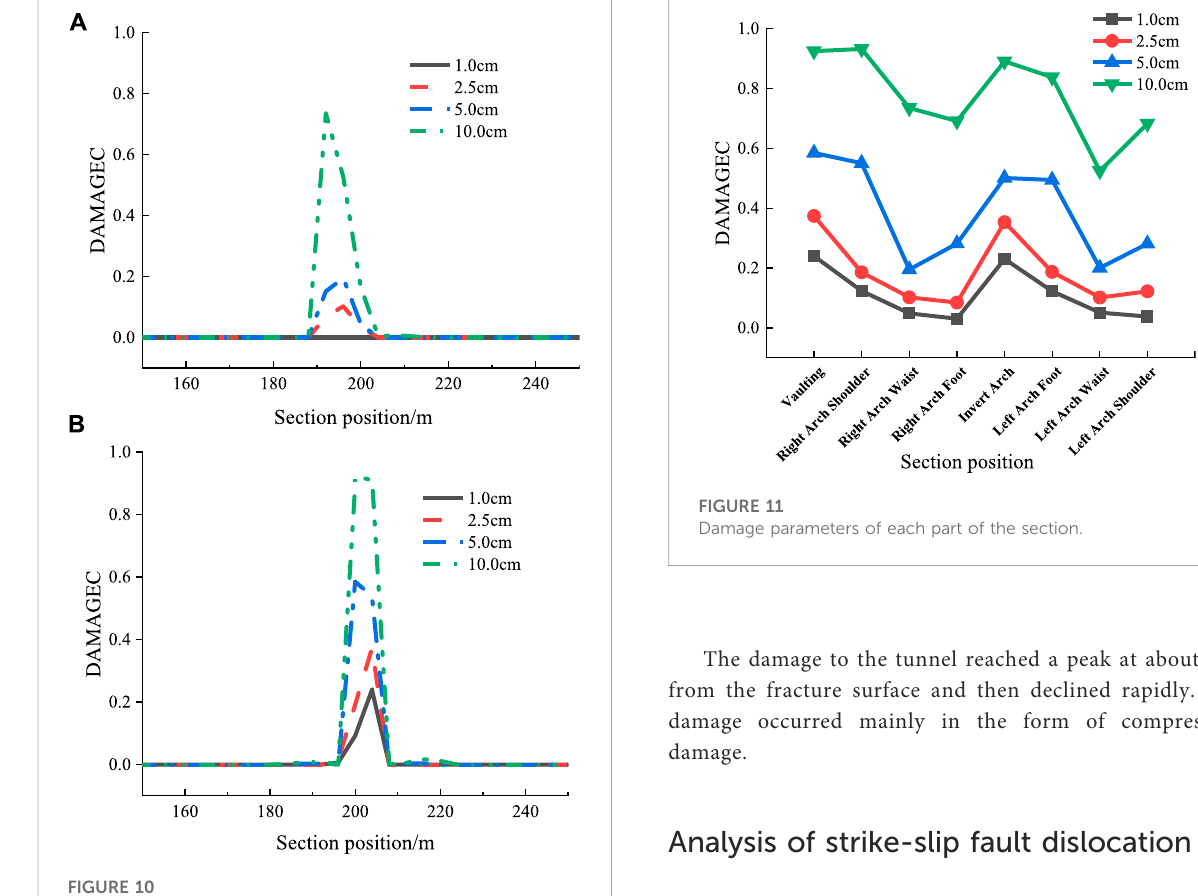
FIGURE 10 Damage evolution of strike-slip faults. (A) Tunnel cross- section DAMAGEC at the arch waist; (B) Tunnel cross-section DAMAGEC at the arch vault.